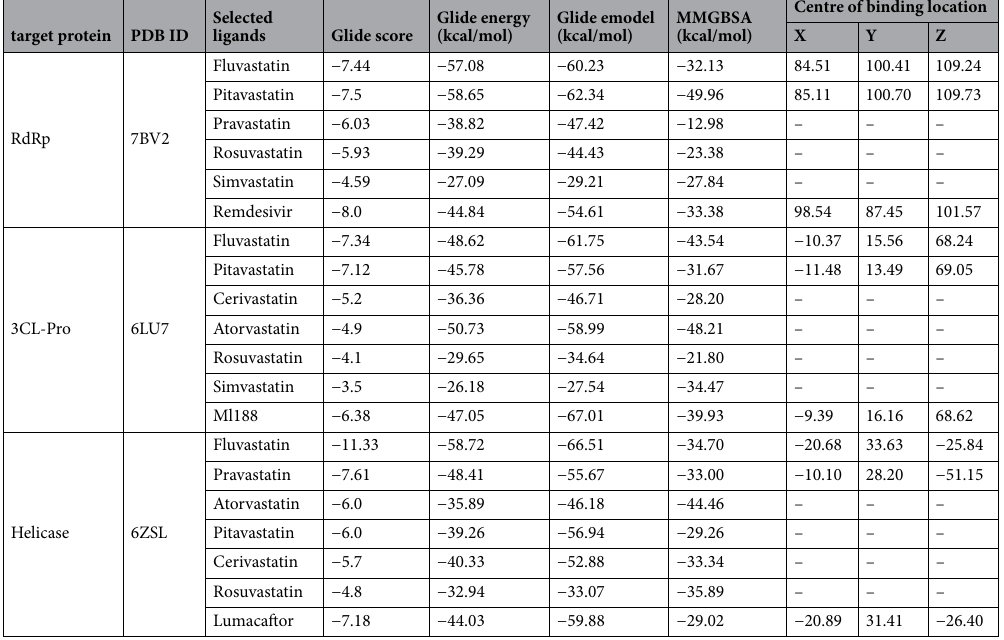
Table 4. Docking analysis of the statins against target proteins of SARS-CoV2, except the spike protein.